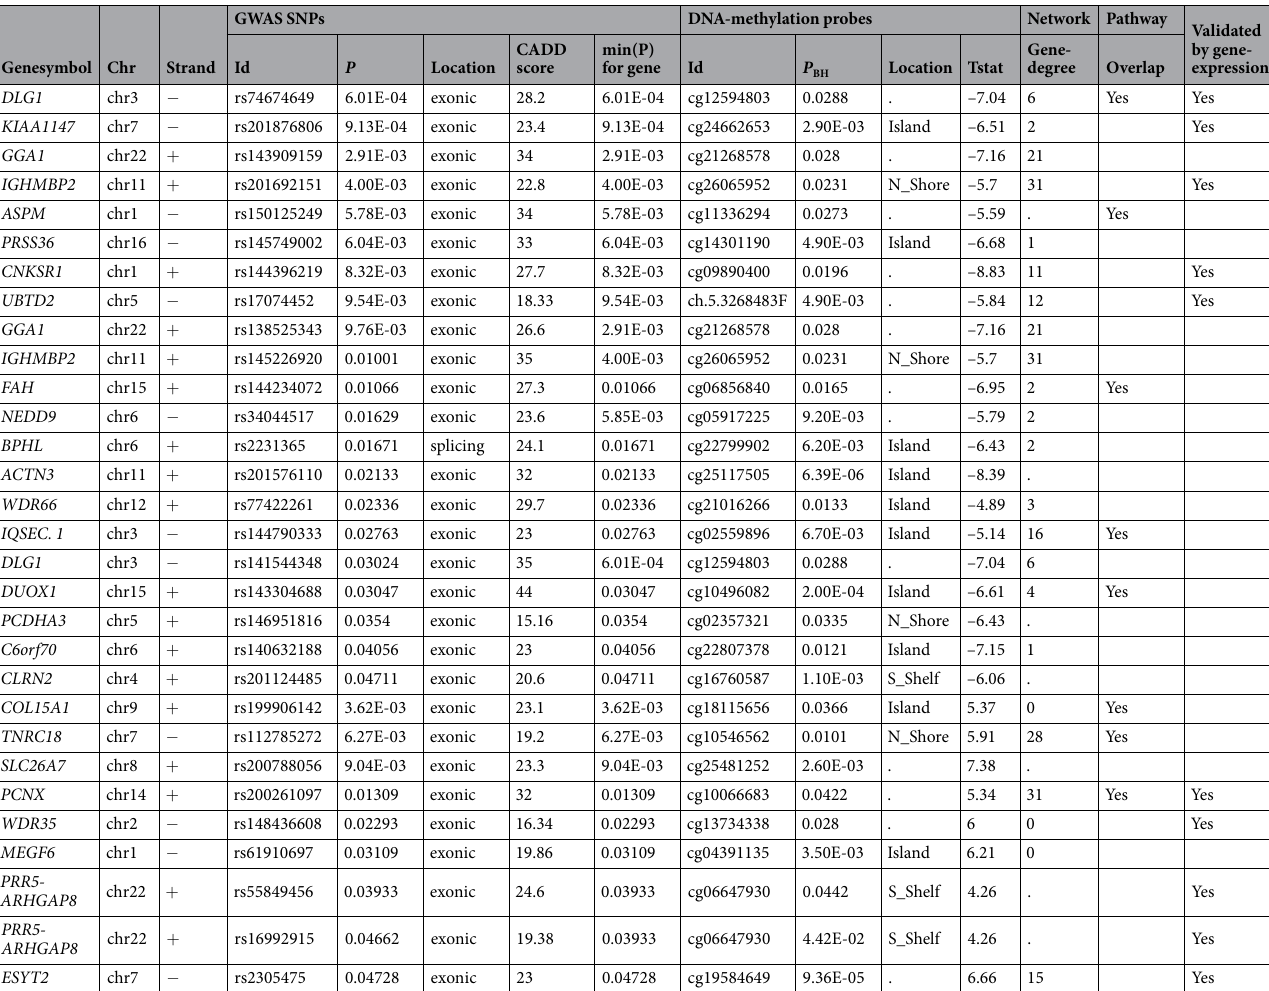
Table 1. Candidate list of genes that display abnormal DNA-methylation levels, and harbor risk-SNPs. Detection of 26 candidate genes for 30 SNPs for FTD-ALS. Genes are grouped in DNA hypomethylated (DMP T-statistics < 0) and hypermethylated genes (DMP T-statistics > 0) followed by P -value significance of GWAS. Chr: Chromosome. GWAS P: P -value significance for the phenotype association. GWAS CADD score: quantifies the deleteriousness of the SNP in the gene (the higher the worse). GWAS min(P) for gene: Minimum P -value significance for the phenotype association without excluding intronic, and intergenic SNPs. DMP P BY : P-value for the DNA-methylation difference between FTD-ALS vs Control cases after multiple test correction using Benjamini and Hochberg. DMP T-stat: T-statistics. Network Gene-degree: the number of edges the gene contains in the co-expression network (Fig. 4). Pathway overlap: [Yes], if the gene overlaps with any of the pathways derived from DMP or GWAS (Fig. 3A and B). Validated by gene-expression: [Yes], if the gene showed significant differential expression in any of the validation data